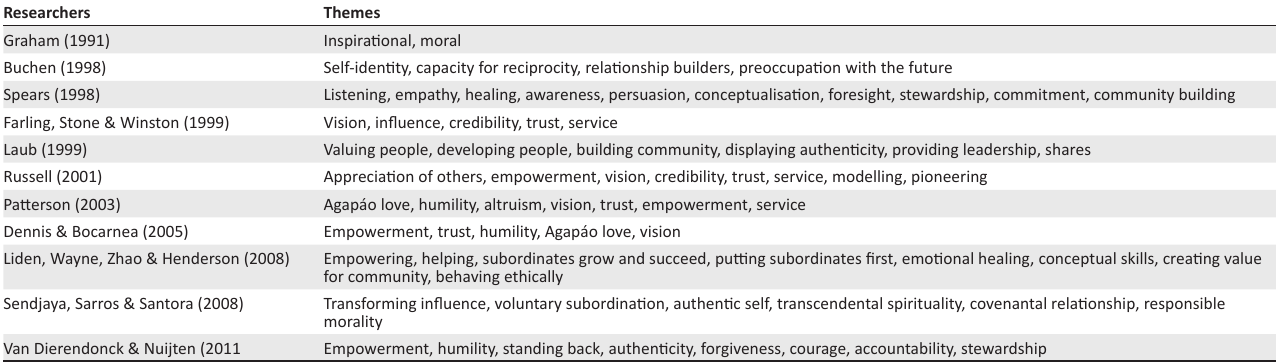
TABLE 1: The dominant themes of servant leadership.